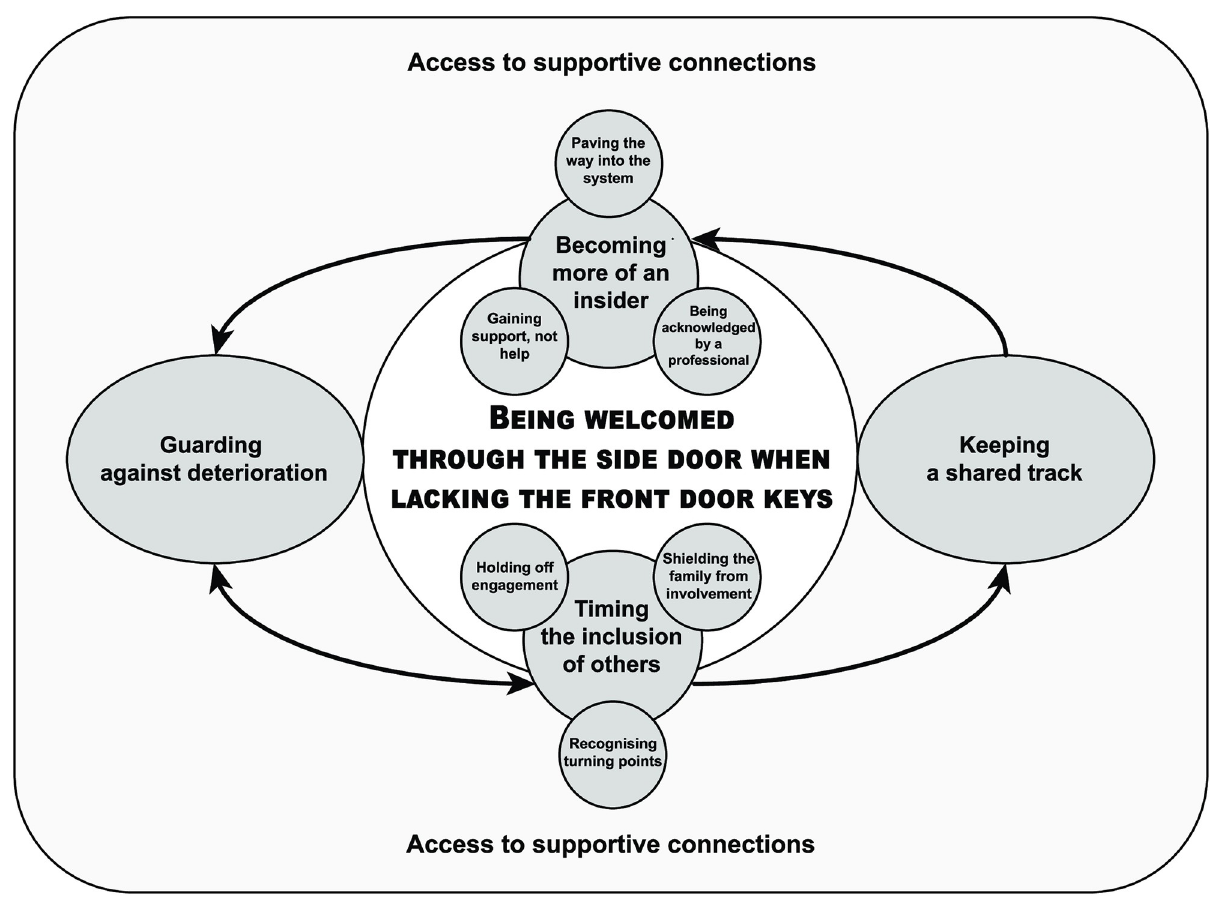
Fig 1. The core category, categories and subcategories describing patients’ experience of the e-health intervention.